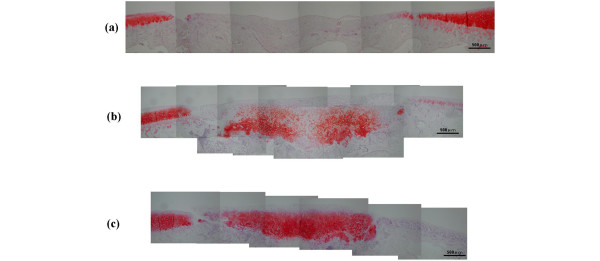
Photomicrographs of cartilage defect lesions in rabbits. (a) Group with control (untreated) defects (group C); and groups given tissue-engineered cartilage implants at (b) 4 weeks after implantation (group T-4) and (c) 12 weeks after implantation (group T-12). Safranin-O–fast-green staining; original magnification × 2.5.